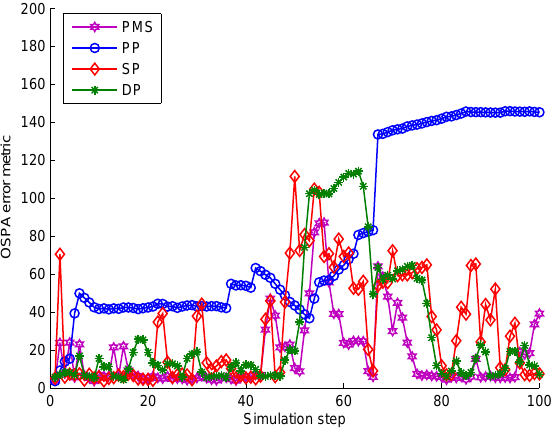
Figure 5. The comparison of four approaches in optimal sub-pattern assignment (OSPA)